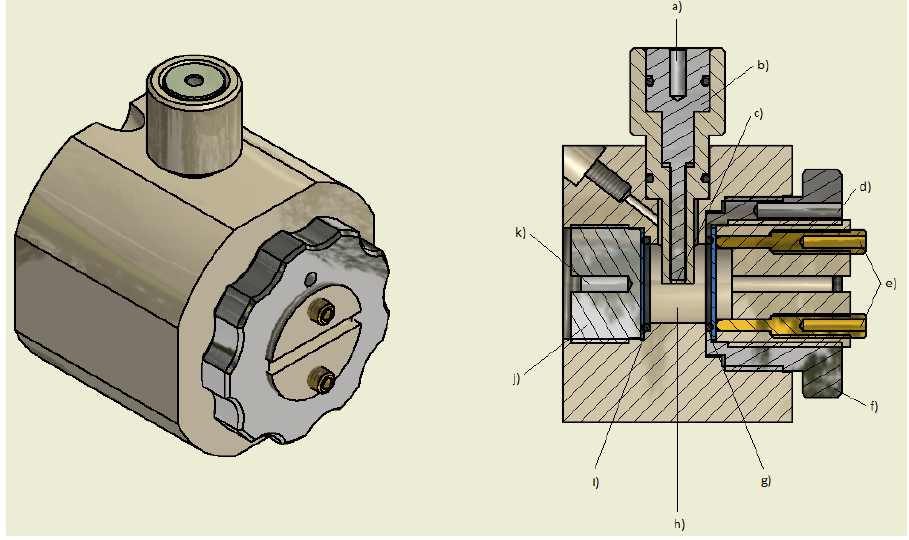
Figure 15. EQCM cell and its various components: ( a ) blind hole for jack plug (RE); ( b ) stainless steel bolt to contact the Li foil RE; ( c ) Li foil RE; ( d ) blind hole for jack plug (WE); ( e ) gold bolts to contact the copper foil quartz at the back side; ( f ) stainless steel winding to contact the copper foil quartz at the front side; ( g ) copper foil on quartz; ( h ) measurement chamber; ( i ) Li foil CE; ( j ) stainless steel plug to fix and to contact the Li foil CE; ( k ) blind hole for jack plug